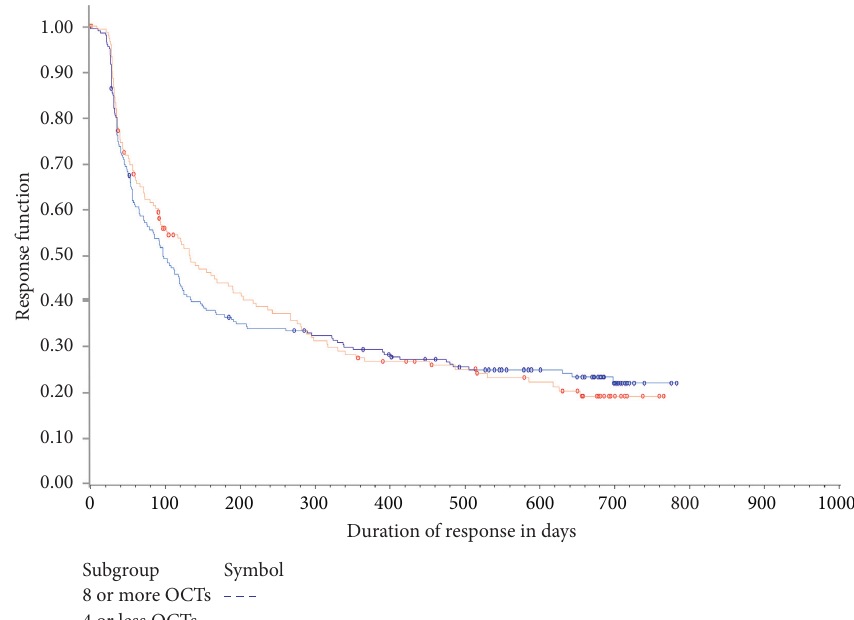
Figure 7: Duration-of-response of ≥ 15 letters for patients receiving ≤ 4 OCTor ≥ 8 OCTexaminations. OCT: optical coherence tomography.